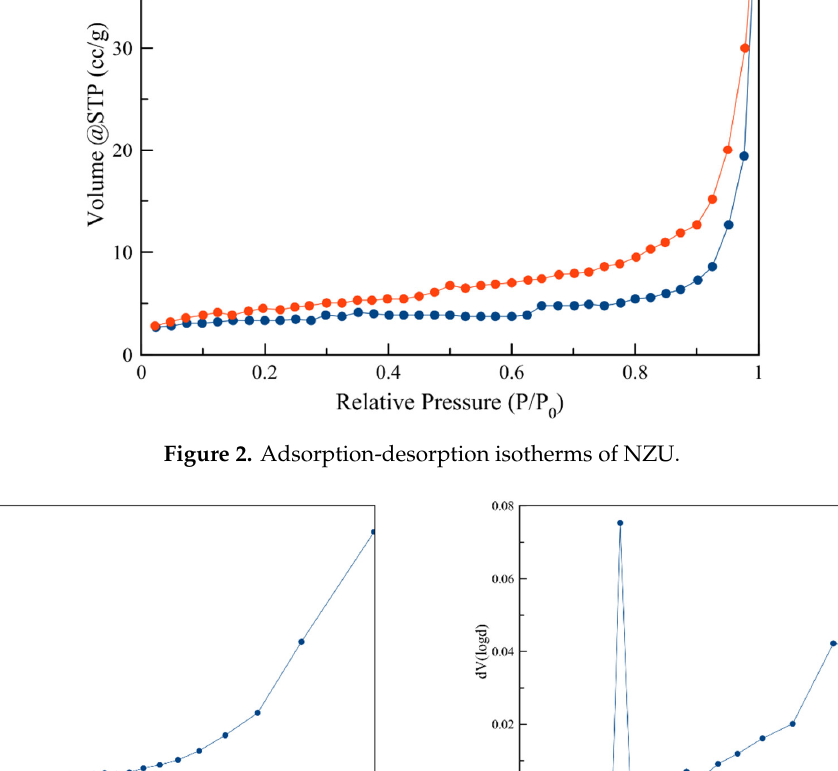
Table 2. X-Ray Fluorescence (XRF) results in wt%.